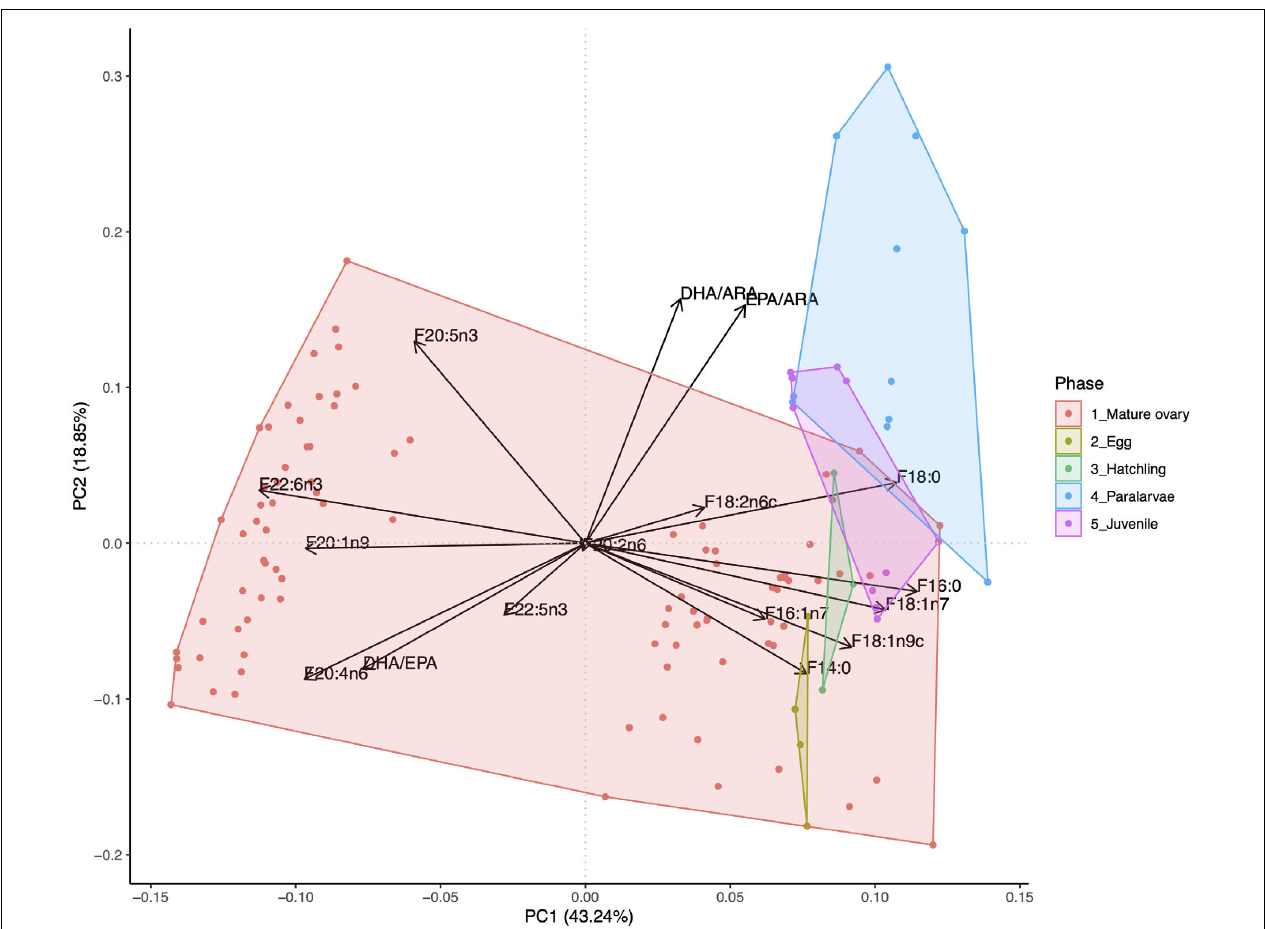
FIGURE 8 | Principal component analysis showing the contribution of each analyzed fatty acid from mature ovaries studied in this work as compared to data sourced from the literature ( Supplementary Table 1 ) of different wild life stages. See Supplementary Figure 11 for a PCA excluding the most extreme left values corresponding to ovaries from year